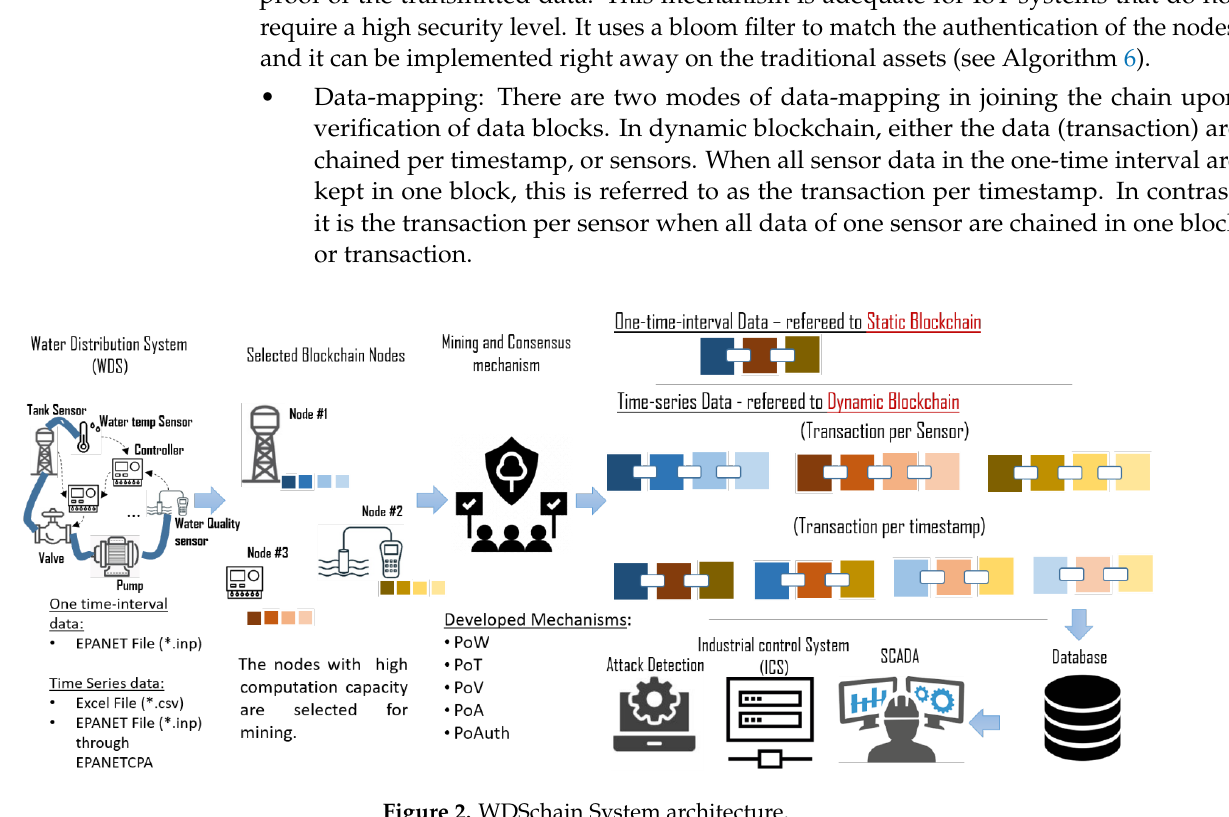
Figure 2. WDSchain System